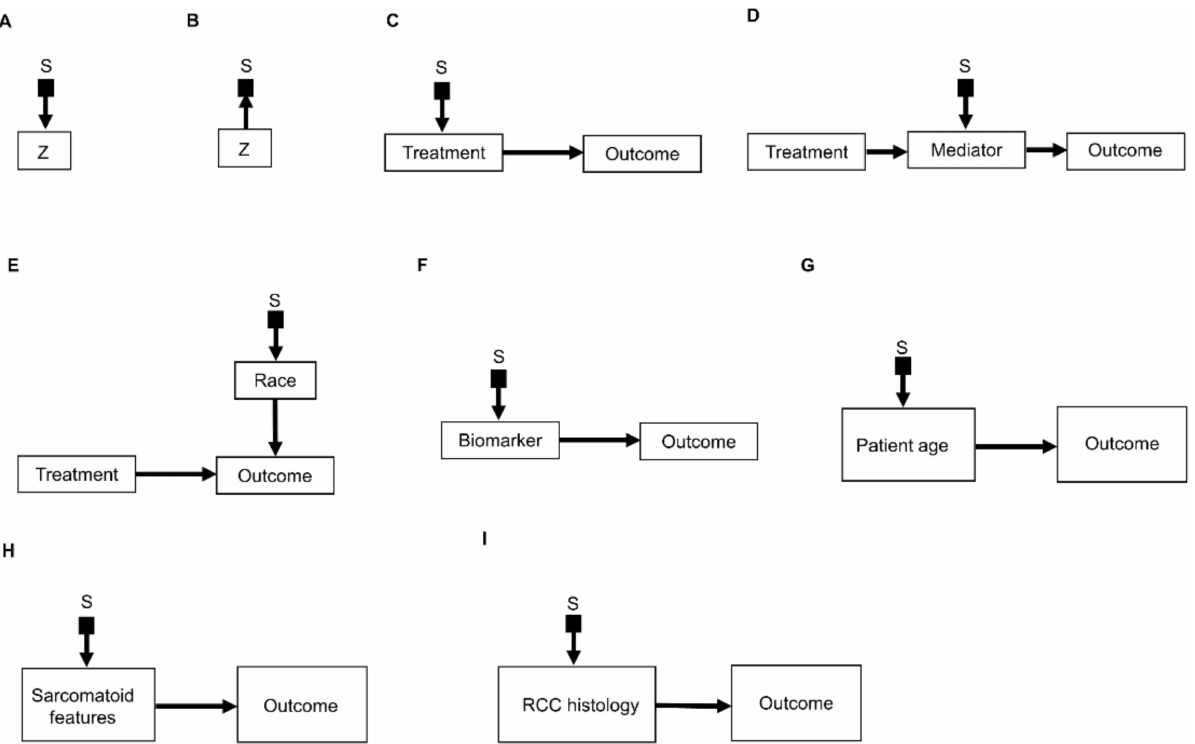
Figure 3. Examples of causal relationships represented by selection diagrams to guide transportability of causal effects across populations: ( A ) Selection node S indicating shifts across populations in the variable Z. In this scenario, the possible values of Z inherently differ between populations; ( B ) Selection node S indicating selection bias for the variable Z. In this scenario, the differences in Z between populations are due to sampling biases and not due to inherent variation; ( C ) Selection node S indicating treatment shifts across populations; ( D ) Selection node S indicating mediator shifts across populations; ( E ) Selection node S indicating shifts in the race of patients treated in a randomized controlled trial (RCT) performed in the United States, compared with an RCT performed in China. In this diagram, the variable “race” directly influences the outcome of interest and the race of patients enrolled is different between the two RCTs; ( F ) Selection node S indicating shifts in biomarker values across populations; ( G ) Selection node S indicating shifts in patient age across populations; ( H ) Selection node S indicating shifts in the presence or absence of sarcomatoid features across populations; ( I ) Selection node S indicating shifts in RCC histology across